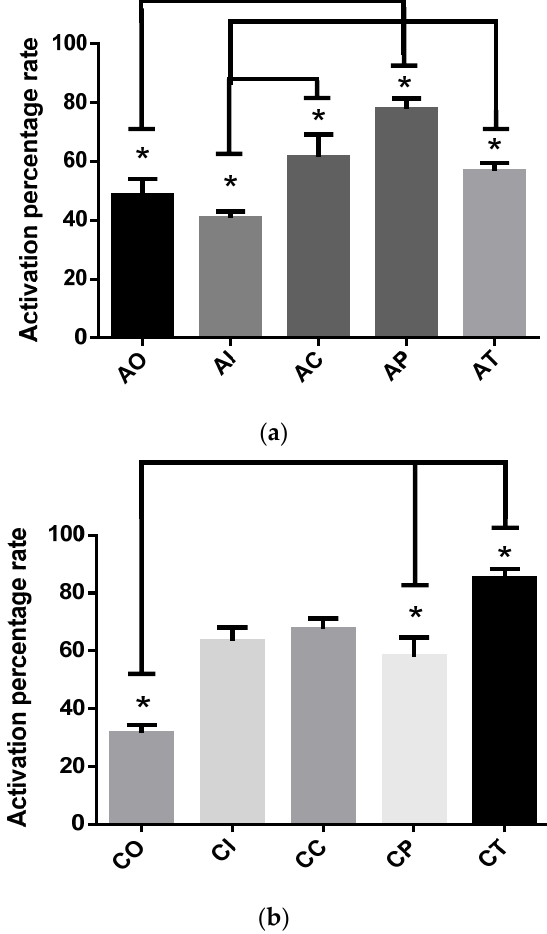
Figure 2. Activation percentage rate of superoxide dismutase in rats exposed to ozone during the acute and chronic phases: ( a ) The preventive dietary curcumin administration increased SOD activity (* p < 0.01) compared to AO, but the therapeutic administration failed to increase the SOD activity; acute O 3 (AO), acute intact (AI), acute CUR (AC), acute preventive (AP), acute therapeutic (AT); ( b ) curcumin in CP and CT groups resulted in a significant SOD increase (* p < 0.01) compared to the CO group. The CI and CC groups exhibited significant increases in SOD activity versus the CO group (* p < 0.01); chronic O 3 (CO), chronic intact (CI), chronic CUR (CC), chronic preventive (CP), chronic therapeutic